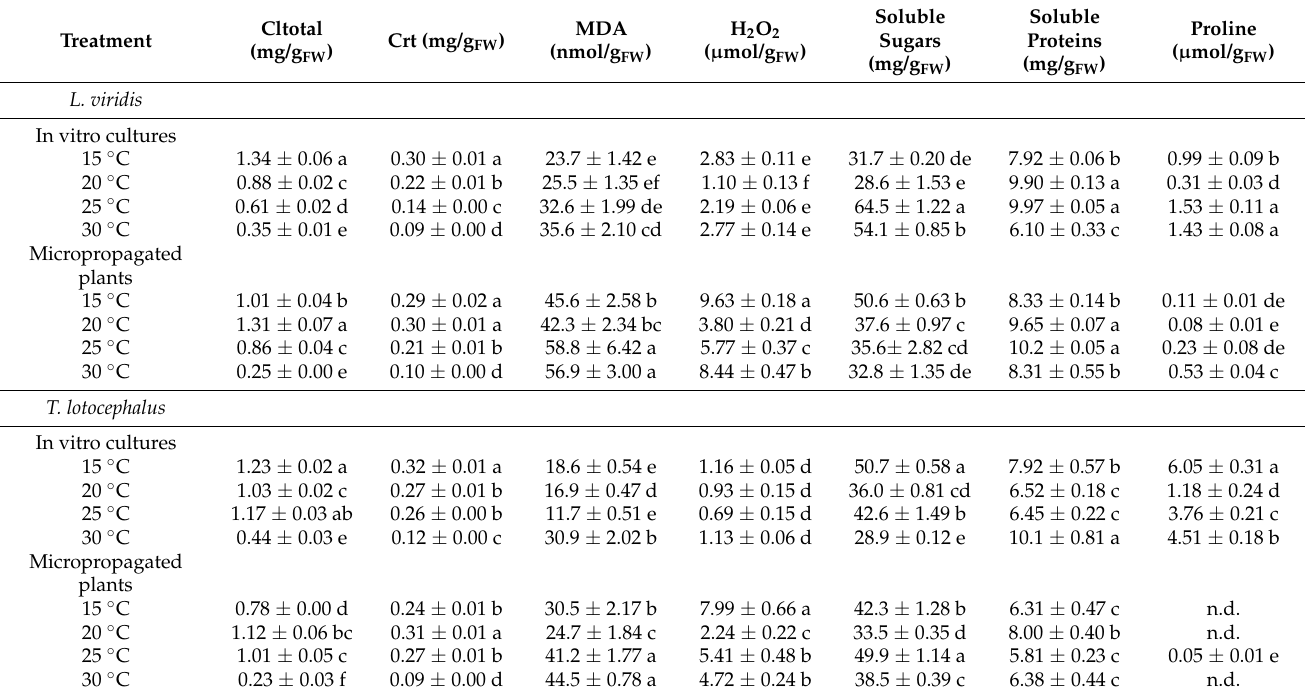
Table 1. Effect of exposure to different temperatures (15, 20, 25, and 30 ◦ C) on Cltotal, Crt, MDA, H 2 O 2 , soluble sugar, soluble proteins, and proline contents of in vitro cultures and micropropagated plants of Lavandula viridis and Thymus lotocephalus